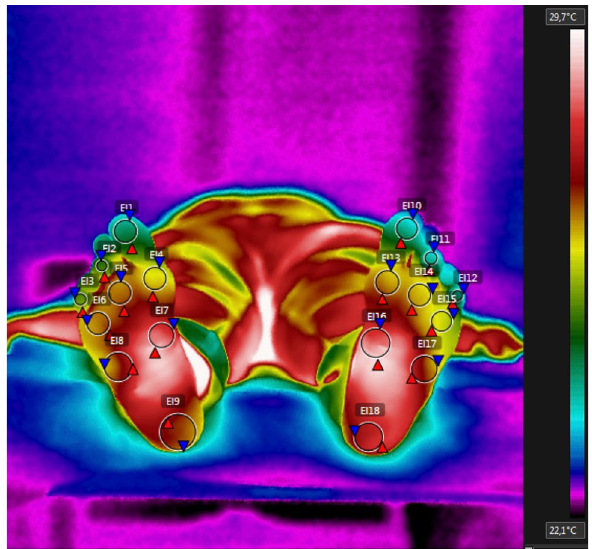
Figure 1. Thermographic image of the regions of interest (ROIs) in the foot. Figure obtained by the FLIR Tools software (https:// www. flir. com. br/ produ cts/ flir-